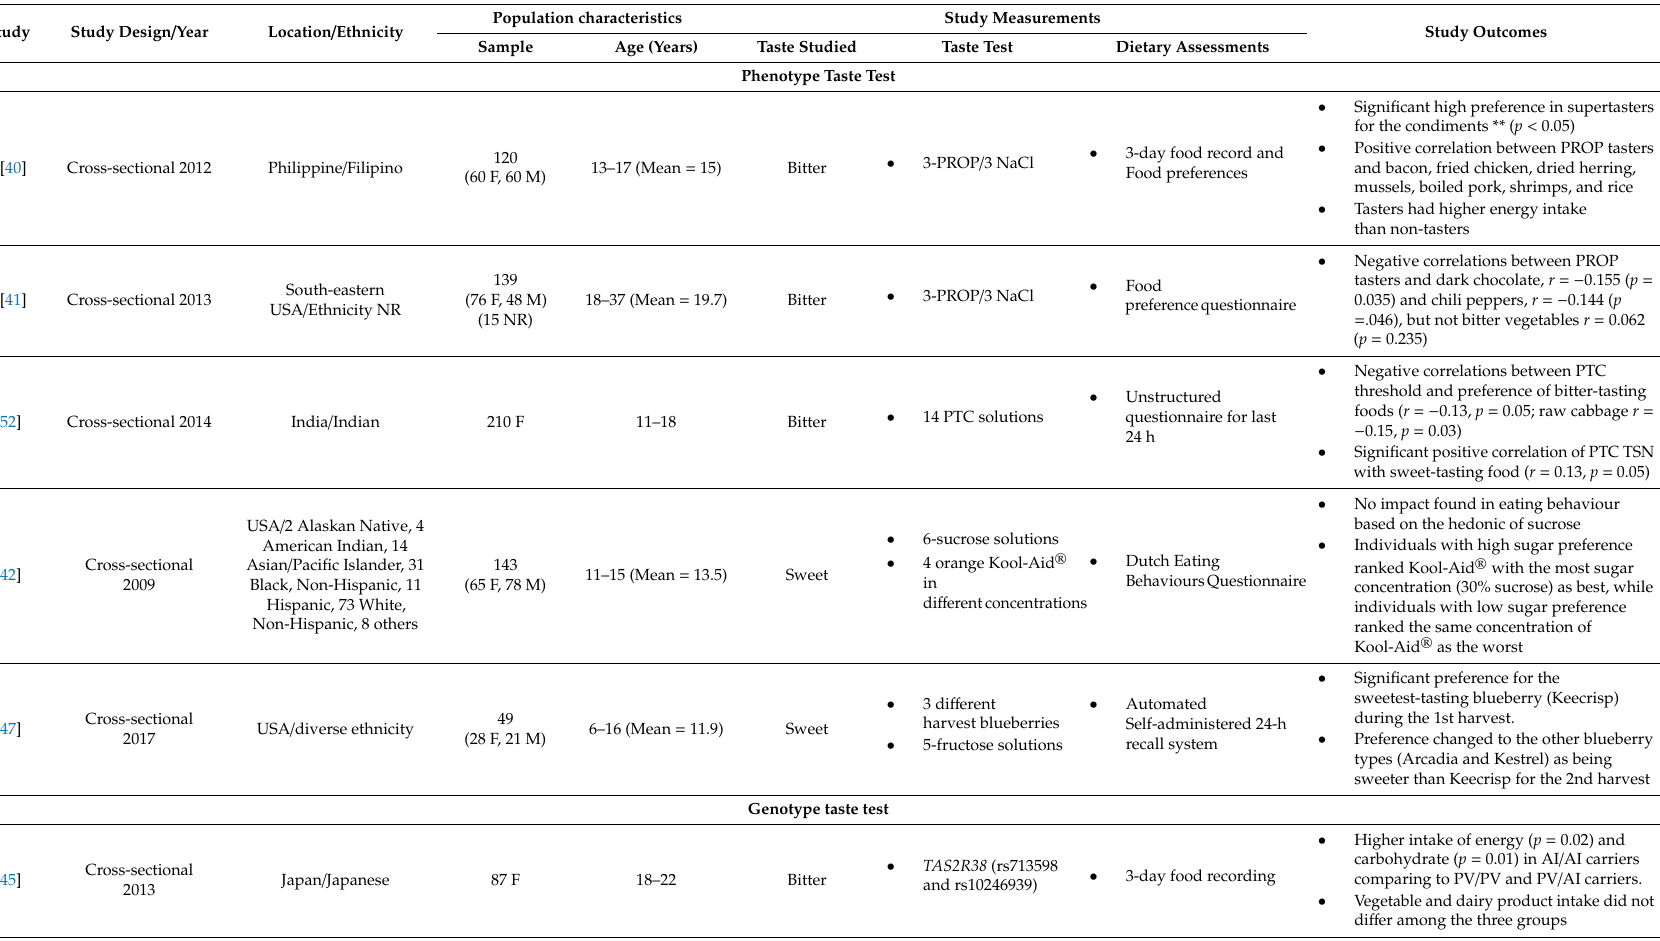
Table 2. Characteristics of the studies using phenotype and genotypes taste tests (separately and in combination) included in the current systematic review /